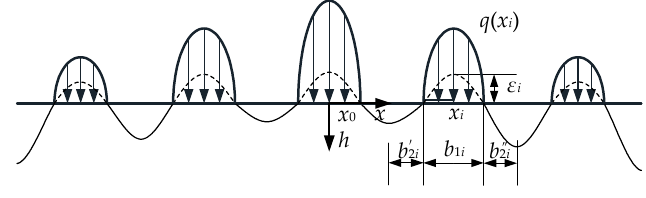
Figure 8. Lens-type sealing gasket micro-contact.